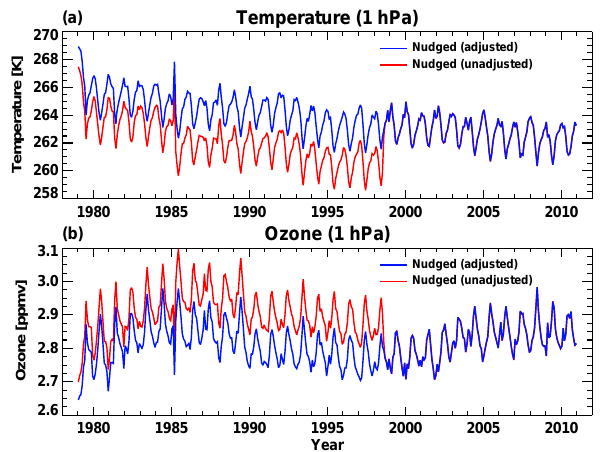
Fig. 7. Global and monthly mean (a) temperature and (b) ozone volume mixing ratio at 1hPa for the adjusted (blue) and unadjusted (red) nudged runs. After August 1998 the red curve underlies the blue since no adjustment is applied then.